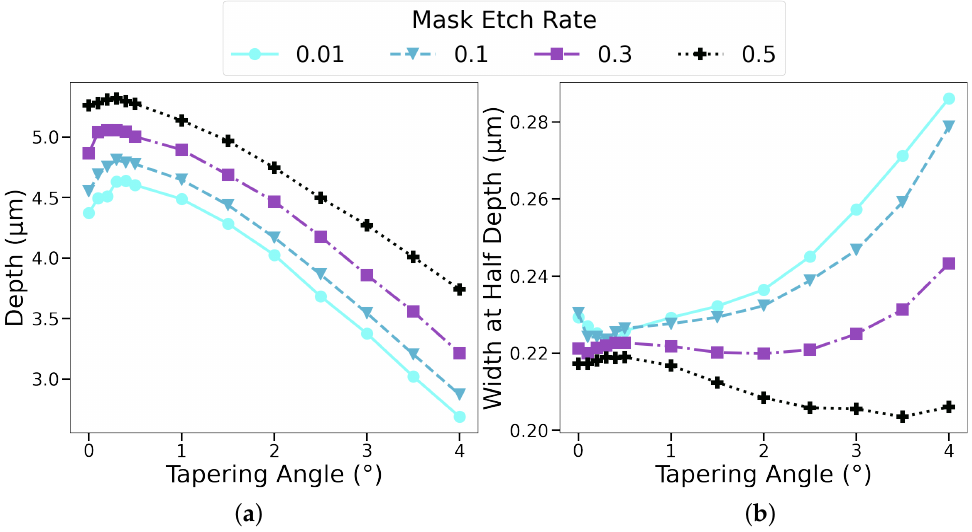
Figure 10. Impact of the mask etch rate on the depth and WAHD of the etched profile. ( a ) The highest vertical etch rate is achieved when the entire mask is etched away. ( b ) Consequently, this scenario results in the lowest lateral etch